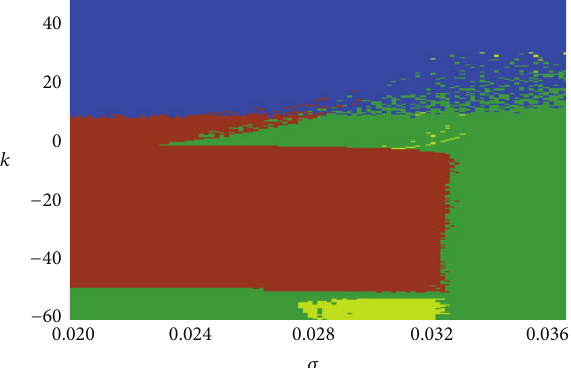
Figure 2: Dynamic behavior distribution diagram of the